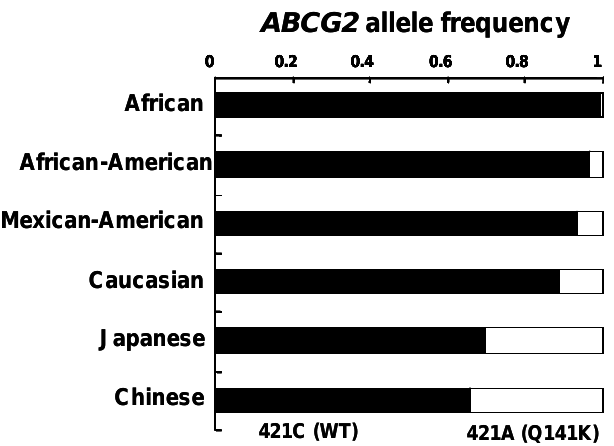
Figure 6. The allele frequencies of 421C (WT) and 421A (Q141K) among different ethnic populations. Data are calculated from Ishikawa et al .